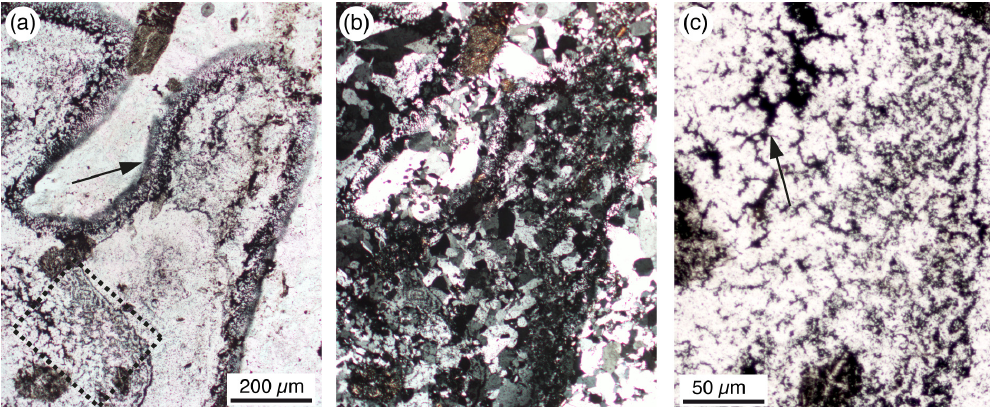
Figure 4. Photomicrographs of blocky anhedral to subhedral quartz from the quartz coating in the Rusey samples. (a) Network-like filamen- tous and/or dendritic textures are made up by dark pigments, most likely micrometer-sized iron oxides, which are restricted by a irregular and diffuse boundary (indicated by the black arrow); the rectangle indicates the position of (c) ; II pol. (b) Quartz is made up by blocky anhedral to subhedral quartz; X pol. (c) A zoom into the dense distribution of the particles reveals that the inclusions form a network-like or dendritic texture (black arrow); II pol. Oriented sample